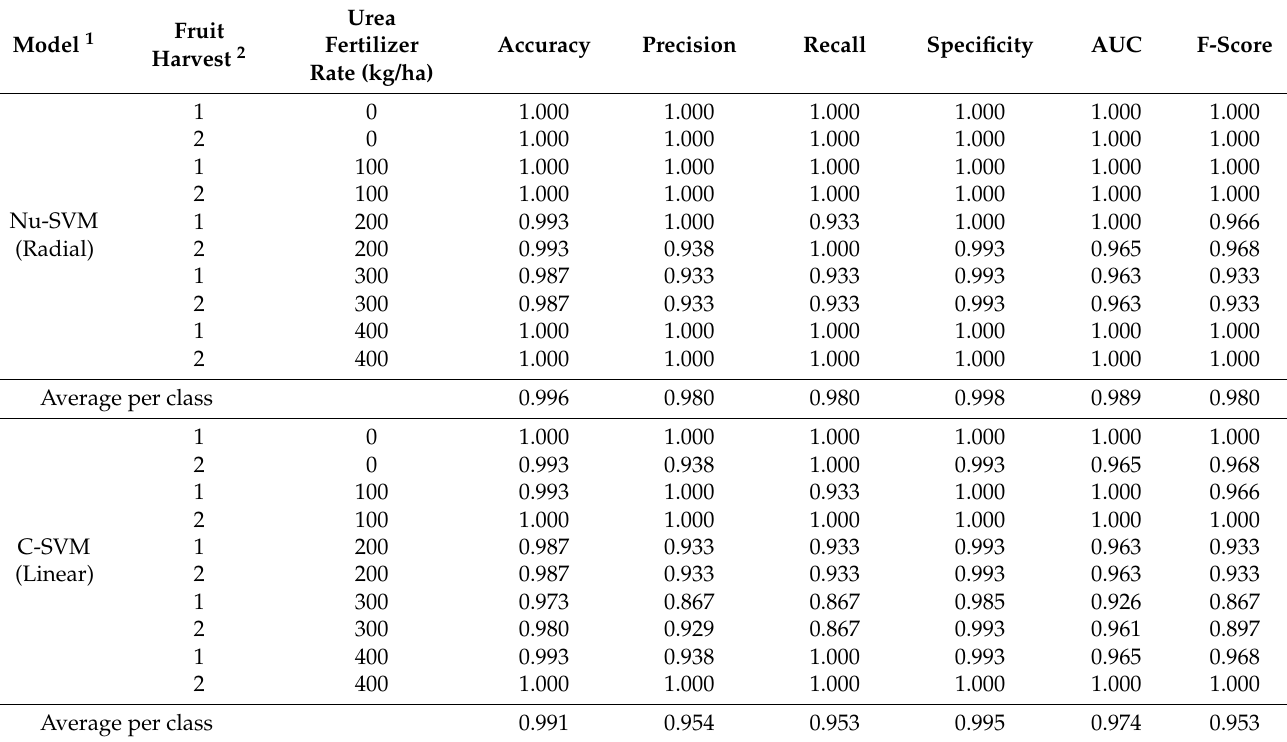
Table 6. Performance parameters of the SVM models for the 10-group classification.